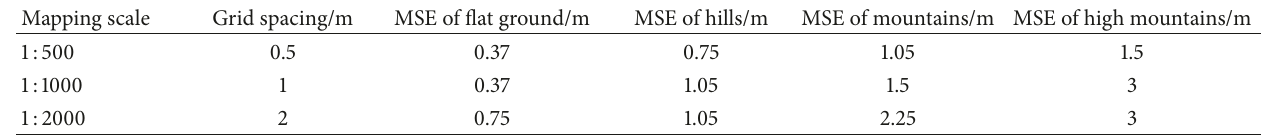
Table 1: 3D topographic